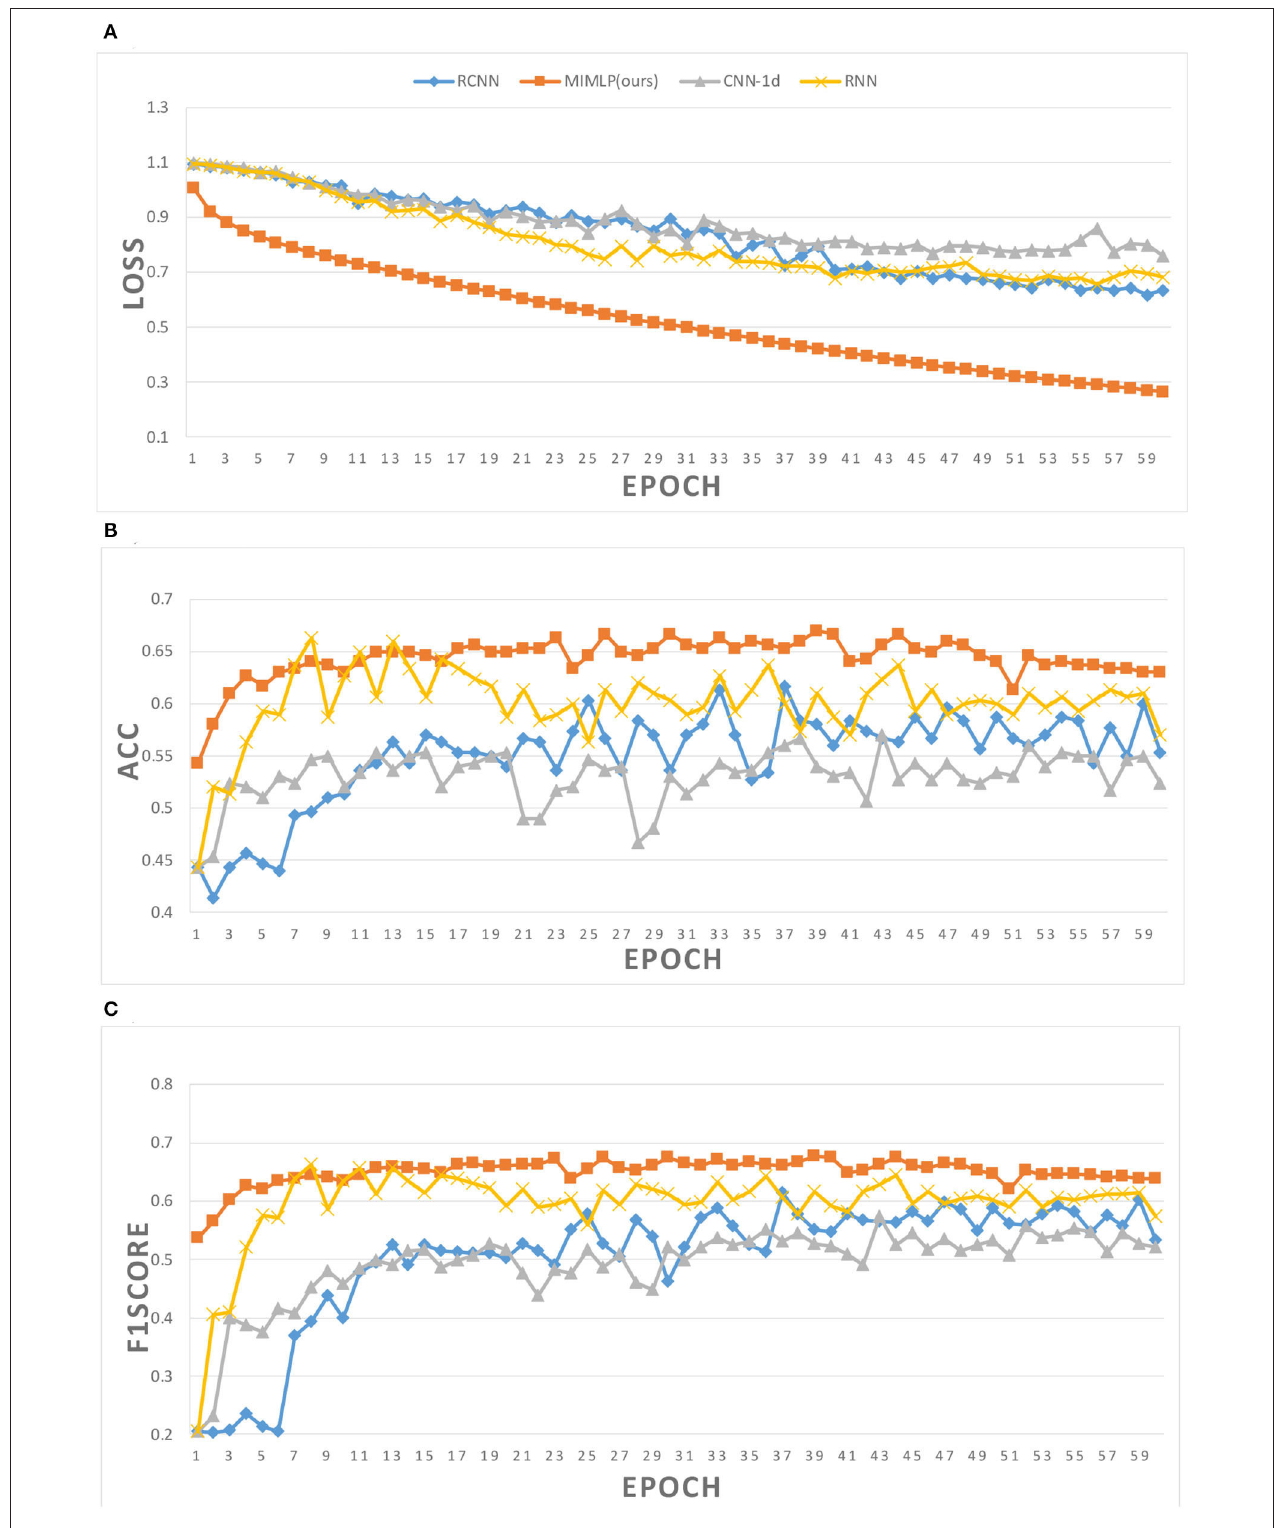
FIGURE 4 | Training details of different models. (A) Loss in training. (B) Accuracy in training. (C) F1score in training.